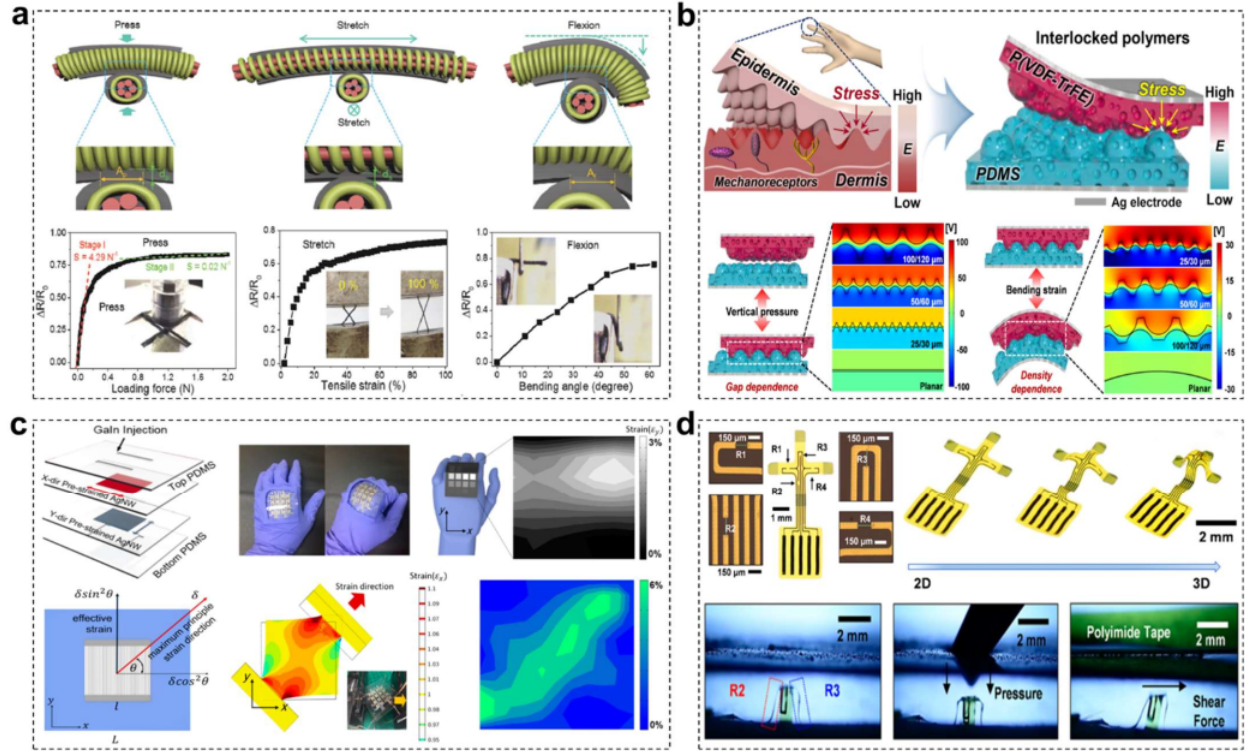
Figure 1. ( a ) Schematic illustration and relative resistance variation of electronic fabric artificial skin in response to pressure, stretching and flexion force. Reprinted with permission [48]. Copyright 2016, Wiley-VCH. ( b ) The epidermis-dermis layer with interlocked micro-ridges in human skin and the skin-inspired nanostructured e-skin. Schematic illustration and theoretical calculation of the gap distance change of the resultant electronic sensors under vertical pressure and bending strain. Reproduced with permission from ref. [50]. Copyright 2018 American Chemical Society. ( c ) Schemat- ics of the multidimensional strain sensor with X-directional and Y-directional pre-strained AgNW. Demonstration of applications of multidimensional strain sensors to map the strain distribution for hand grip motion. Reprinted with permission from ref. [58] (Copyright 2015 American Chemical Society) ( d ) Optical images of 2D precursor that have two piezoresistors (R2 and R3) in the vertical direction and the other two (R1 and R4) in the horizontal direction, and their 3D structure evolutions during the mechanical buckling processes. The bottom images are the microscopic pictures of the as-fabricated sensor in response to normal force and shear force. Reprinted with permission [60]. Copyright 2019, American Chemical